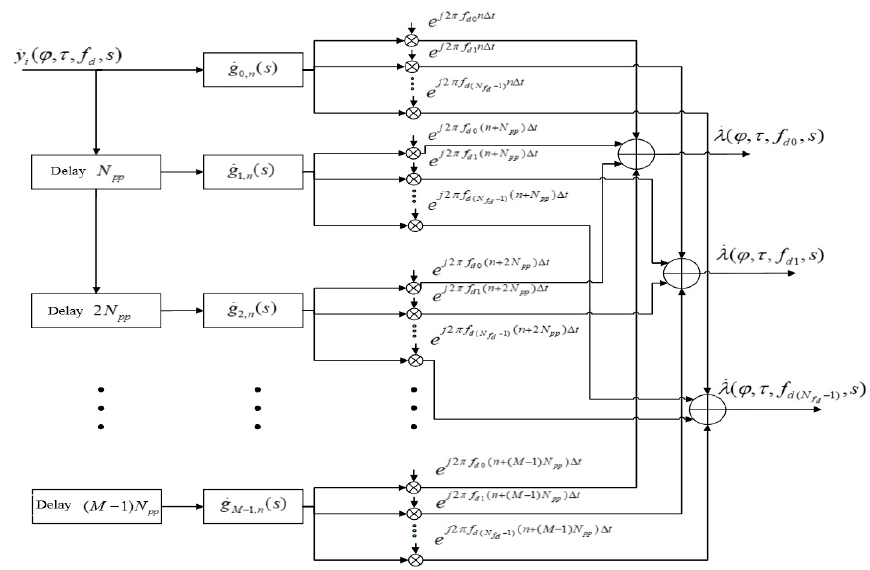
Figure 2. Matched filter with a series of sequences with complex exponents. Joint detection and signal parameters estimation device scheme is shown in Figure 3.